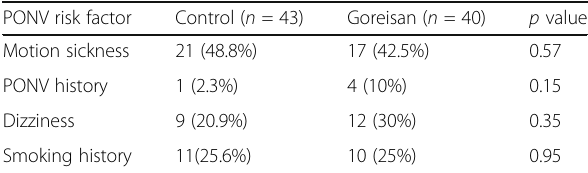
Table 2 Preoperative PONV risk factors